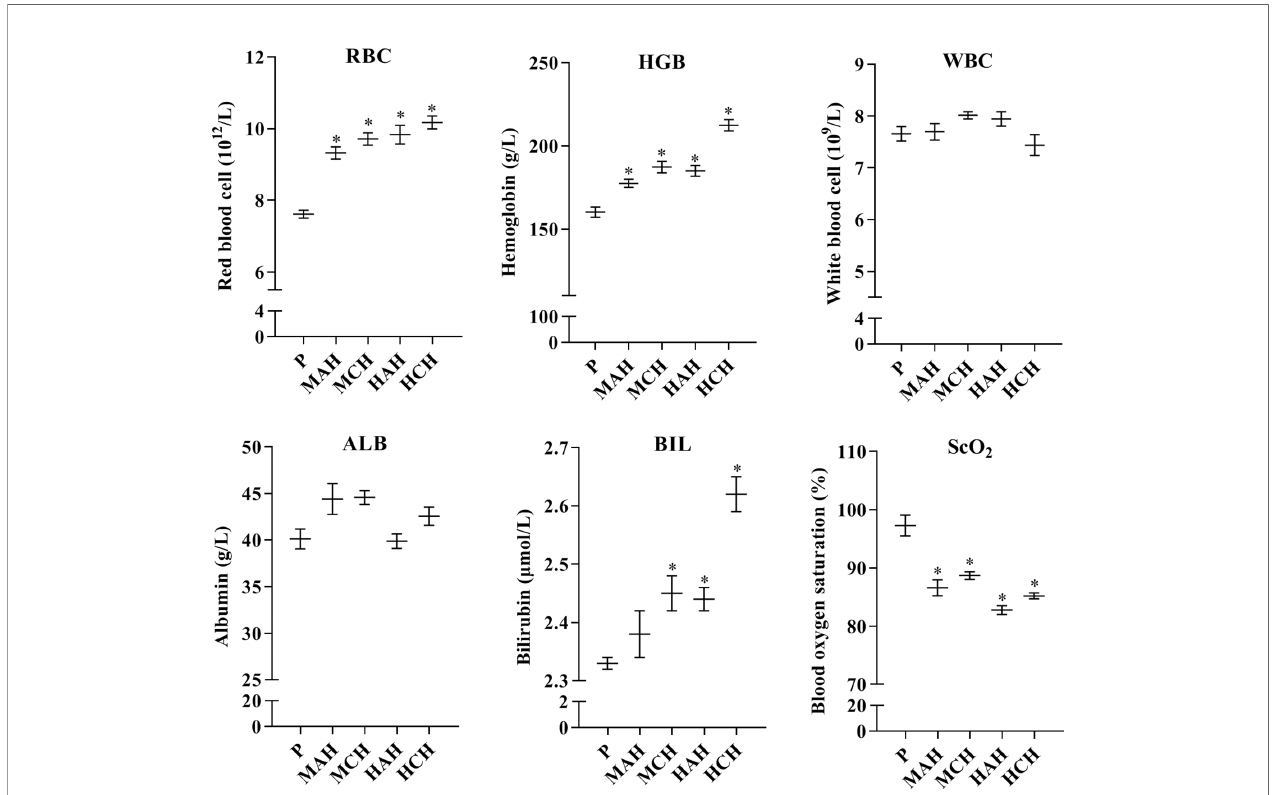
FIGURE 1 | Changes in red blood cells, white blood cells, hemoglobin, blood oxygen saturation, albumin, and bilirubin from rats after exposure hypoxia. P: plain group (altitude: 390 m, PaO 2 : 20 kPa), MAH: acute moderate-altitude hypoxia group (altitude: 2,800 m, PaO 2 : 15.1 kPa; Rats were exposed to moderate altitude for 24 h), MCH: chronic moderate-altitude hypoxia group (altitude: 2,800 m, PaO 2 : 15.1 kPa; Rats were exposed to moderate altitude for 30 days), HAH: acute high- altitude hypoxia group (altitude: 4,300 m, PaO 2 : 12.4 kPa; Rats were exposed to high altitude for 24 h), HCH: chronic high-altitude hypoxia group (altitude: 4,300 m, PaO 2 : 12.4 kPa; Rats were exposed to high altitude for 30 days). The data were analyzed using a one-way analysis of variance (ANOVA), and the differences between the means of two groups were compared using LSD tests. * indicates the signi fi cance of experimental groups, compared with that of the control. Values are expressed as Mean ± SEM (n = 10). Levels are considered signi fi cant at * p <